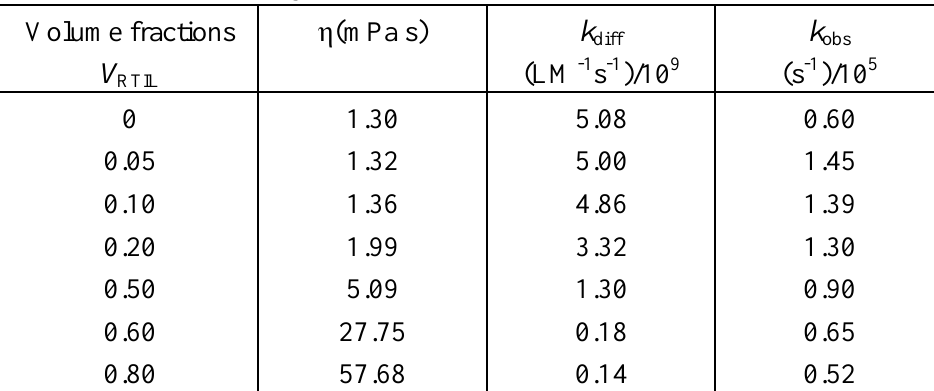
Table 1. Decay rate constants, diffusion rate constants of 1 · 10 -4 mol (cid:215) dm